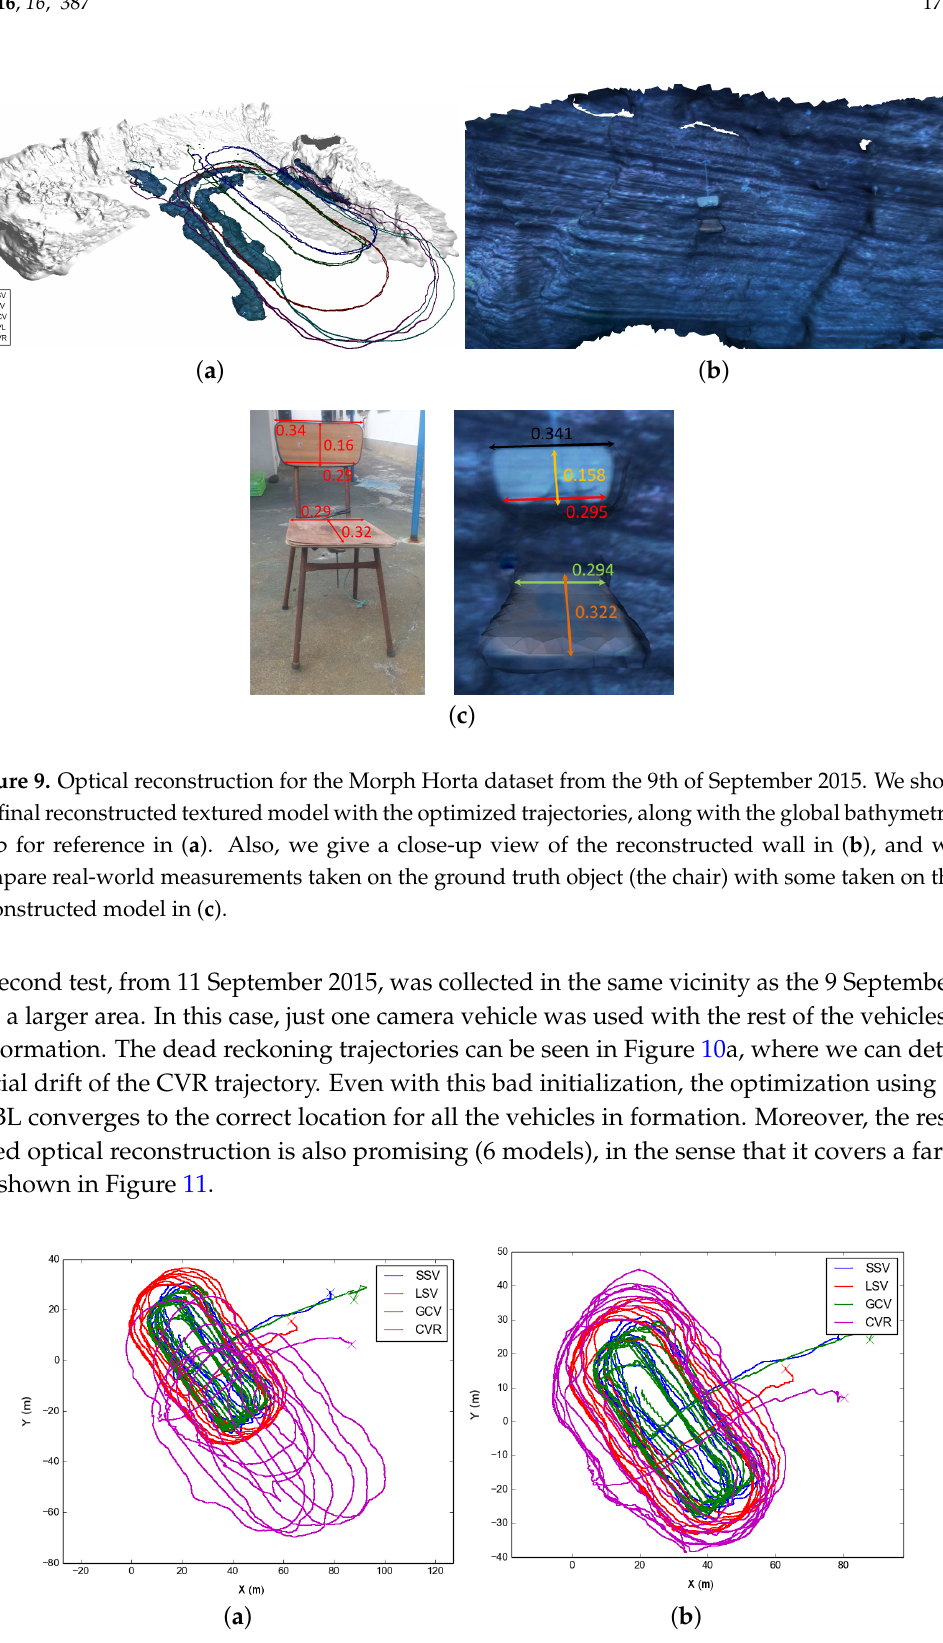
Figure 10. Morph Horta dataset at 11 September 2015: dead reckoning ( a ) and optimized trajectories ( b